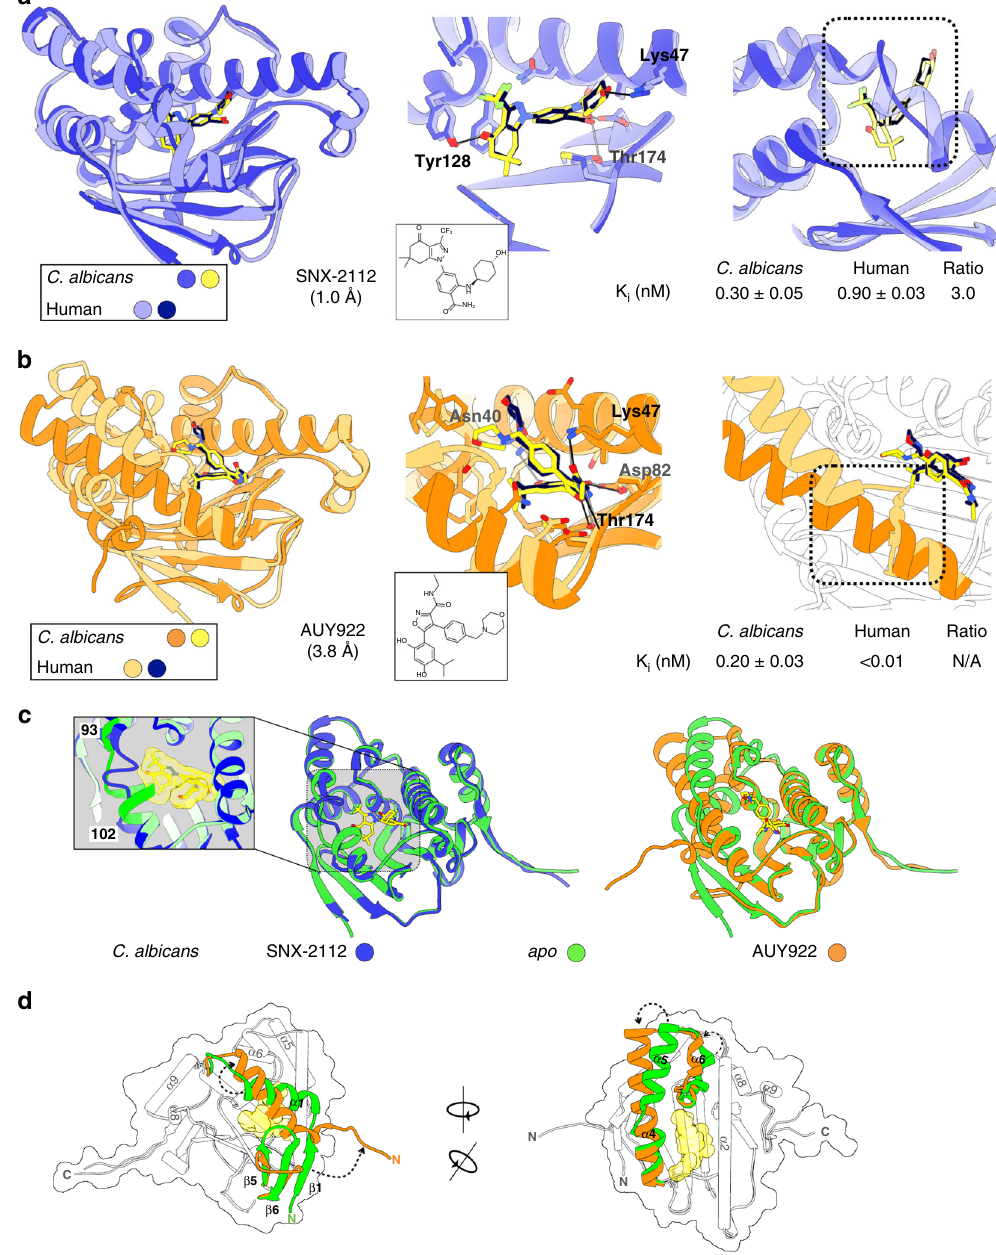
Fig. 2 Comparison of inhibitor-bound structures for C. albicans vs human Hsp90 NBD. a Detailed view of the binding mode of SNX-2112 to C. albicans Hsp90 nucleotide-binding domain (NBD) (dark blue), overlaid with a human Hsp90 α NBD structure in complex with SNX-2112 (light blue; PDB id. 4NH7). Several of the C. albicans Hsp90 residues interacting with the compound are identi fi ed, and the conformation of the 93 – 102 region is indicated by a dotted rectangle. Binding af fi nities for the compound were determined by equilibrium competition FP assay using puri fi ed human and fungal NBDs. K i values are indicated below the structures. The mean ± SEM of three independent experiments is presented. b Detailed view of the binding mode of AUY922 to C. albicans Hsp90 NBD (orange), overlaid with a human Hsp90 α NBD structure in complex with the same compound (light orange; PDB id. 2VCI). Several C. albicans Hsp90 residues interacting with the compound are identi fi ed. The helical conformation of the 93 – 102 region is indicated by a dotted rectangle. Hsp90 NBD binding af fi nities were determined as described for panel a. The mean ± SEM of three independent experiments is presented. c Inhibitor- induced conformational changes in C. albicans NBD. Ribbon representation of C. albicans Hsp90 NBD bound to Hsp90 inhibitors SNX-2112 (left image) and AUY922 (right image). Apo structure (green) is overlaid. Compounds are represented as sticks and color-coded according to heteroatom composition. A detailed view of the conformational differences in the 93 – 102 region between apo and SNX-2112 bound crystal structures is provided; SNX-2112 is shown as sticks and a semitransparent yellow surface. d Views from different angles of the C. albicans Hsp90 NBD in its apo and AUY922-bound states. Overlays of the crystal structures are shown in cartoon/ribbon representation. Secondary structure elements are color-coded to highlight the conformational changes associated with AUY922 binding; dotted arrows indicate the direction of the movement of secondary structure elements. The outline of the apo surface is indicated by a black line, and the AUY922 position is indicated as a semitransparent yellow sphere representation. Source data for the determination of all inhibitory constants are provided as a source data fi